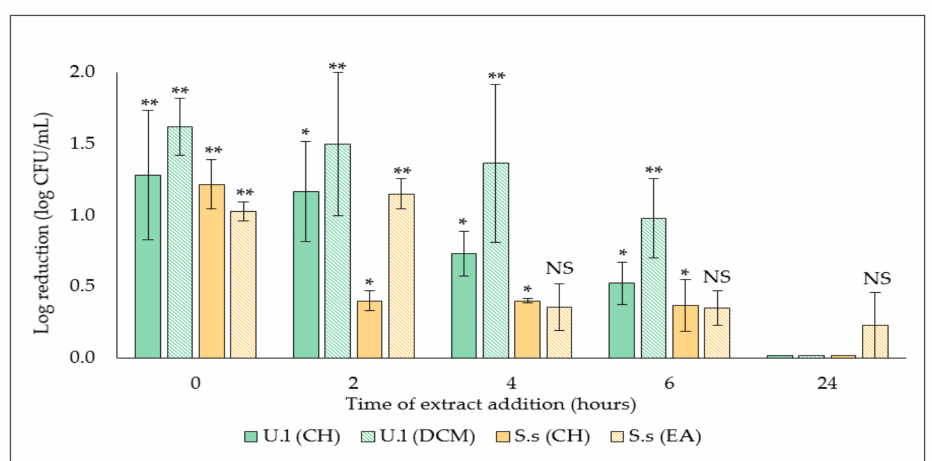
Figure 3. Effect of selected algal extracts (50.0 µ g/mL) on S. aureus biofilm development phases. Extracts were added at different time points (t 0 , t 2h , t 4h , t 6h, and t 24h ). Results are expressed as means of the adhered cells number (log CFU/mL) ± SD from three independent experiments. Statistically significant differences (**, p -value < 0.01, *, p -value < 0.05) between log CFU/mL number with extract treated biofilm and that in the appropriate untreated control are indicated. NS: not significant.